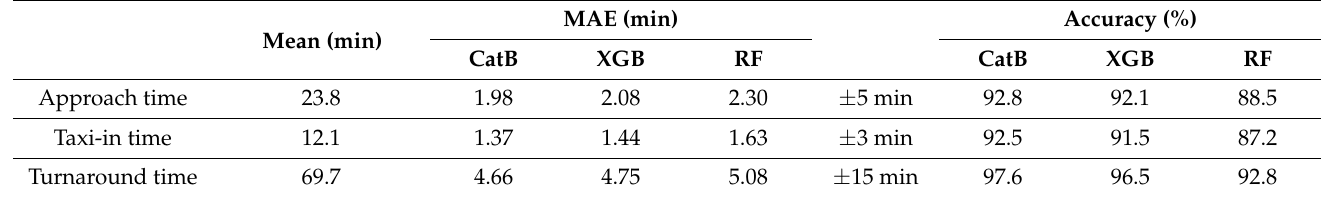
Table 10. Prediction results of approach time, taxi-in time and turnaround